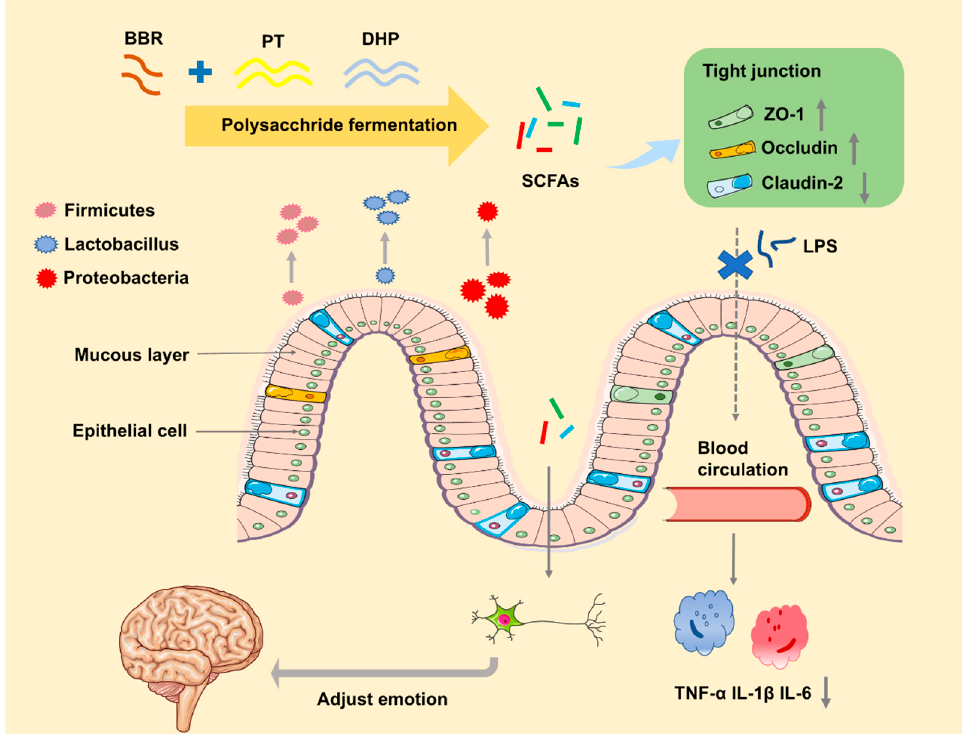
Figure 1. The mechanism of PT and DHP plays a vital role in alleviating the symptom of colitis.